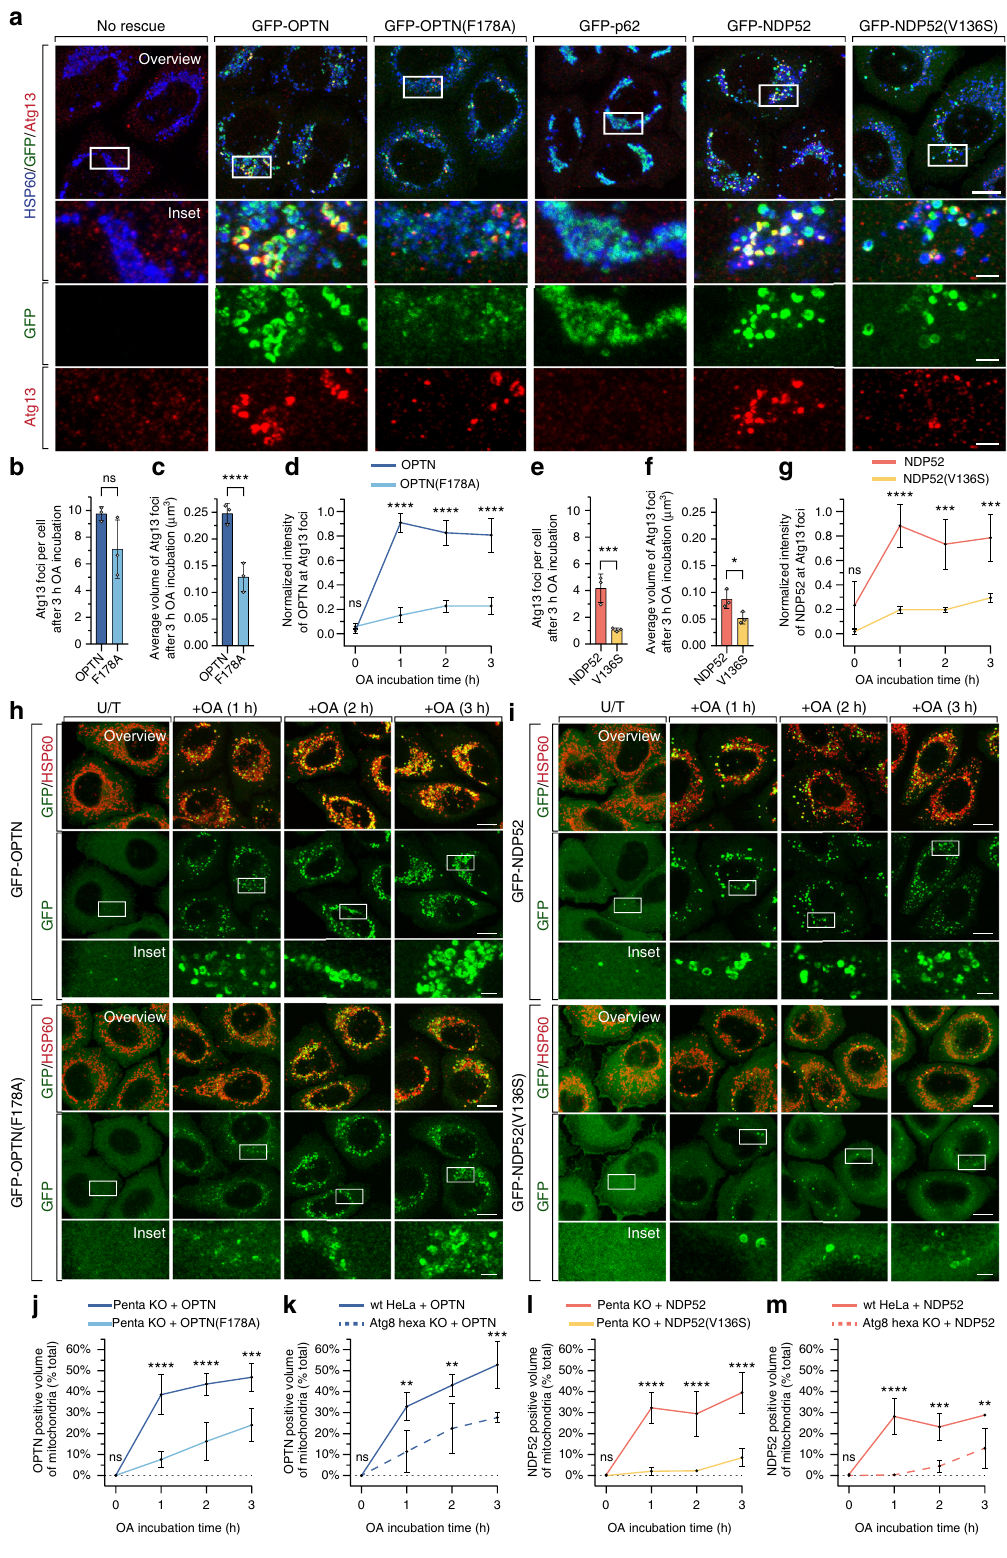
translocated to mitochondria in the presence of GFP-NDP52 (Fig. 4g, l). To con fi rm that the recruitment of UBD mutant autophagy receptors was LIR motif dependent, the experiment was also conducted in cells expressing mCh-OPTN(F178A/ D474N) and mCh-NDP52(V136S/C443K) LIR/UBD double mutants (Fig. 4h – j). Consistent with our hypothesis,